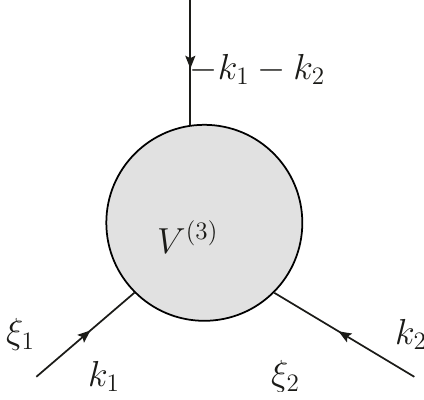
Figure 4 . 1PI vertex involving two external soft particles and one internal soft